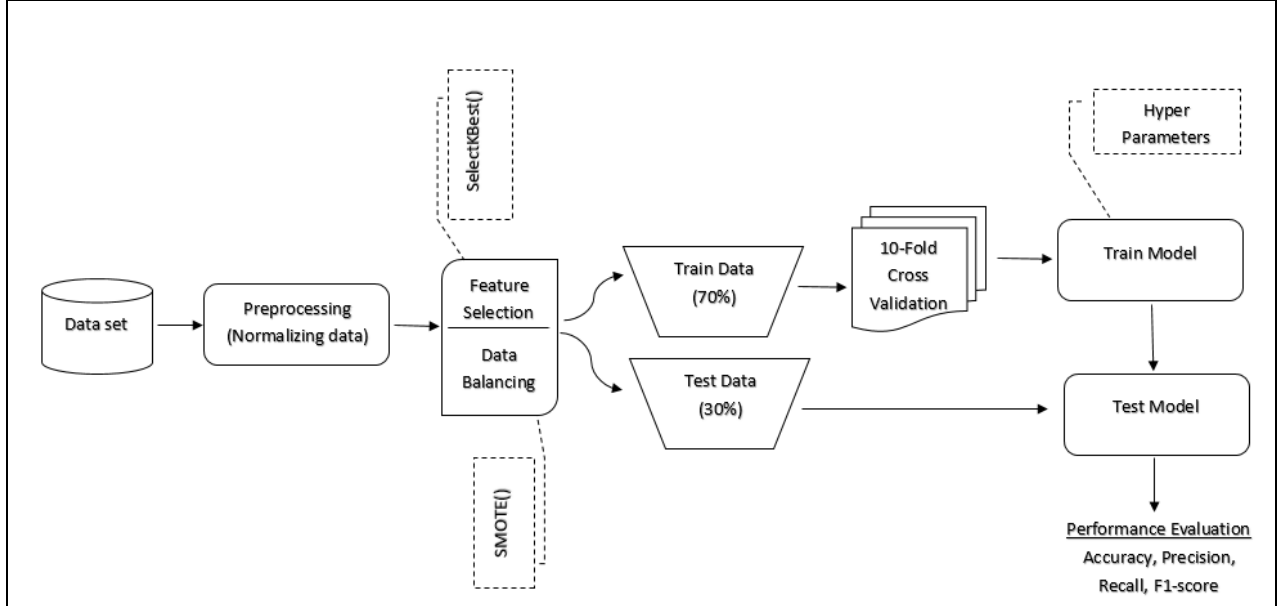
Figure 1. Process flow.